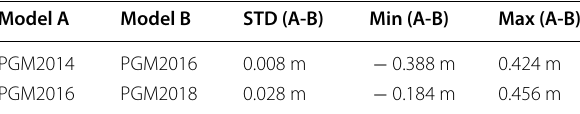
Table 2 Statistics on the residuals of the comparisons